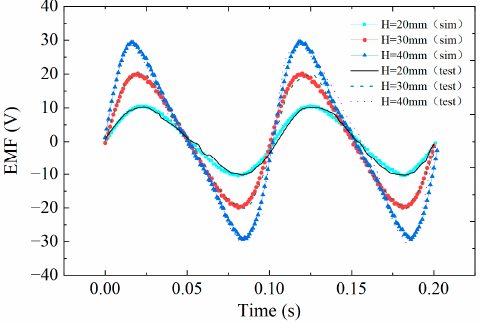
Figure 11. EMF curve of PMLG under different strokes.